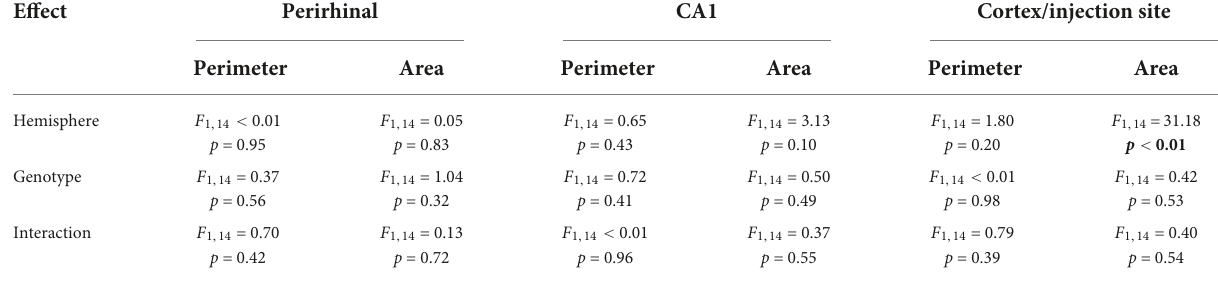
TABLE 3 ANOVA results from perimeter and area data ( Figure 3 ) separated by brain region, histological stain, and